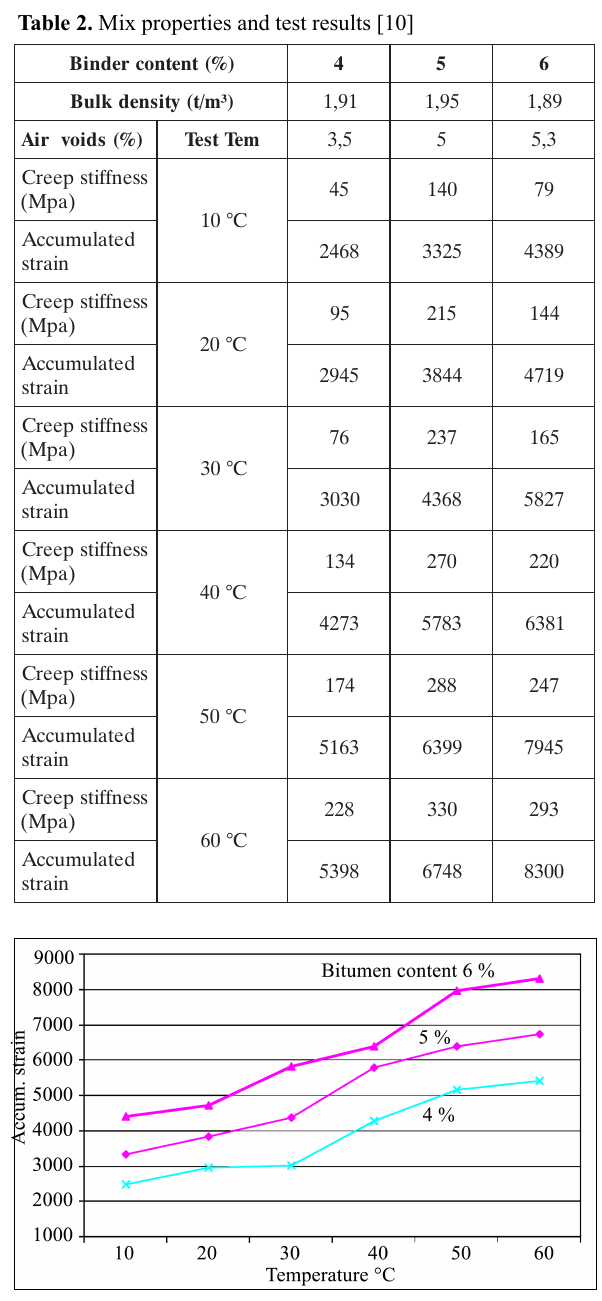
Fig 6. Effect of bitumen content and temperature on accumulated ( ) strain